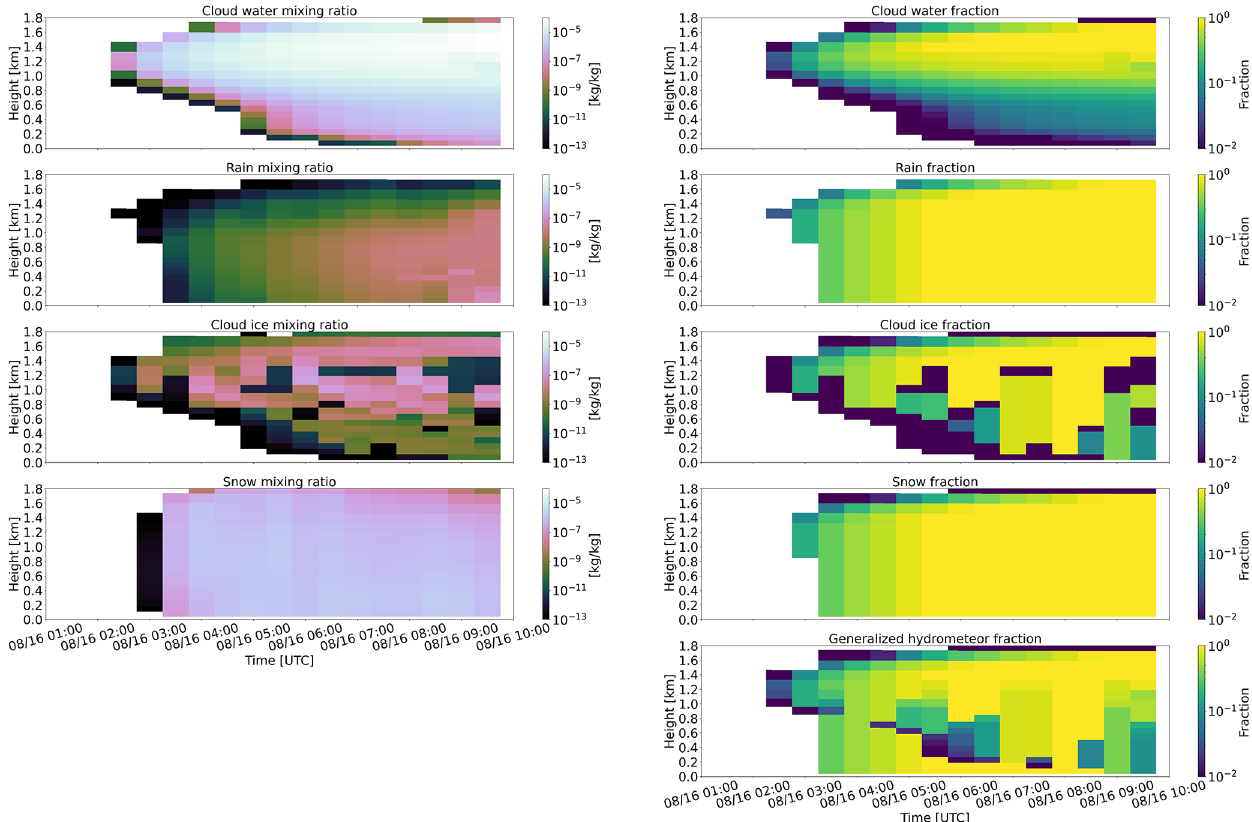
Figure 3. ModelE3 configuration Tun3 single-column model (SCM) output for the Antarctic cloud case study (16 August 2016) showing mixing ratio (left) and hydrometeor fraction (right) time–height curtain plots of (from top to bottom) cloud water, rain, cloud ice, and snow. The generalized hydrometeor fraction used in the radiation approach (see Sect. 2) is depicted in the bottom right